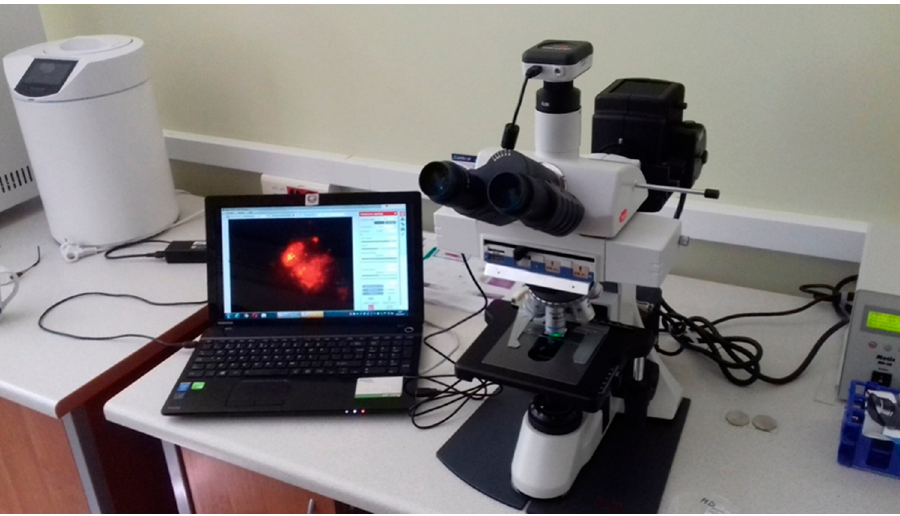
Figure 3. Fluorescence microscope equipped with a special MOTIC light kit and an M2 digital camera used for research. used for